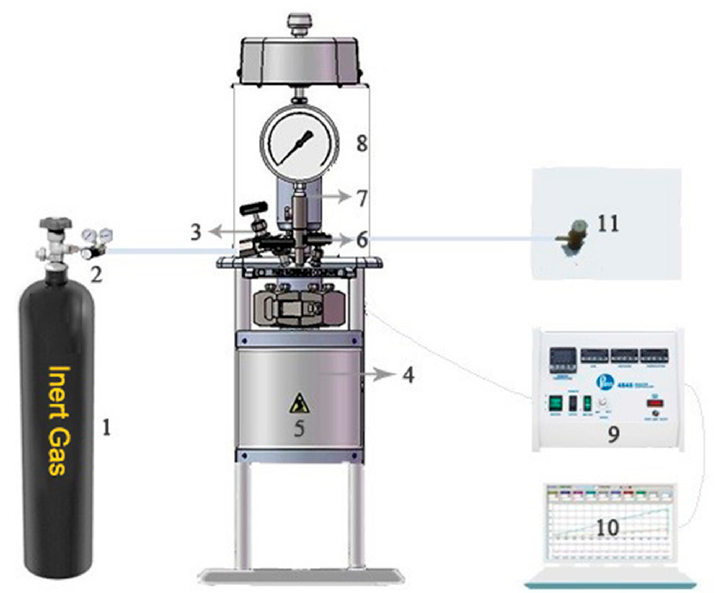
Figure 1. Experimental apparatus used for pyrolysis experiments. 1. Gas cylinder; 2. pressure reducing valve; 3. air inlet valve; 4. autoclave body; 5. heater; 6. air outlet valve; 7. magnetic stirrer; 8. pressure gauge; 9. reaction controller; 10. computer; 11. gas collection bag. Table 1. Different conditional experiments of LDPE pyrolysis by varying the pressure; inert atmo- spheres, such as nitrogen, helium and argon; and additives, such as 1-hexene, 1-octene, 1-decene, octane and